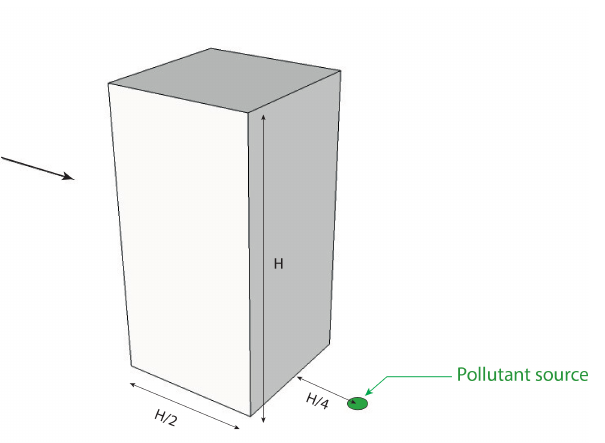
Figure 7. Configuration of the isolated building located in an unstable boundary layer case.